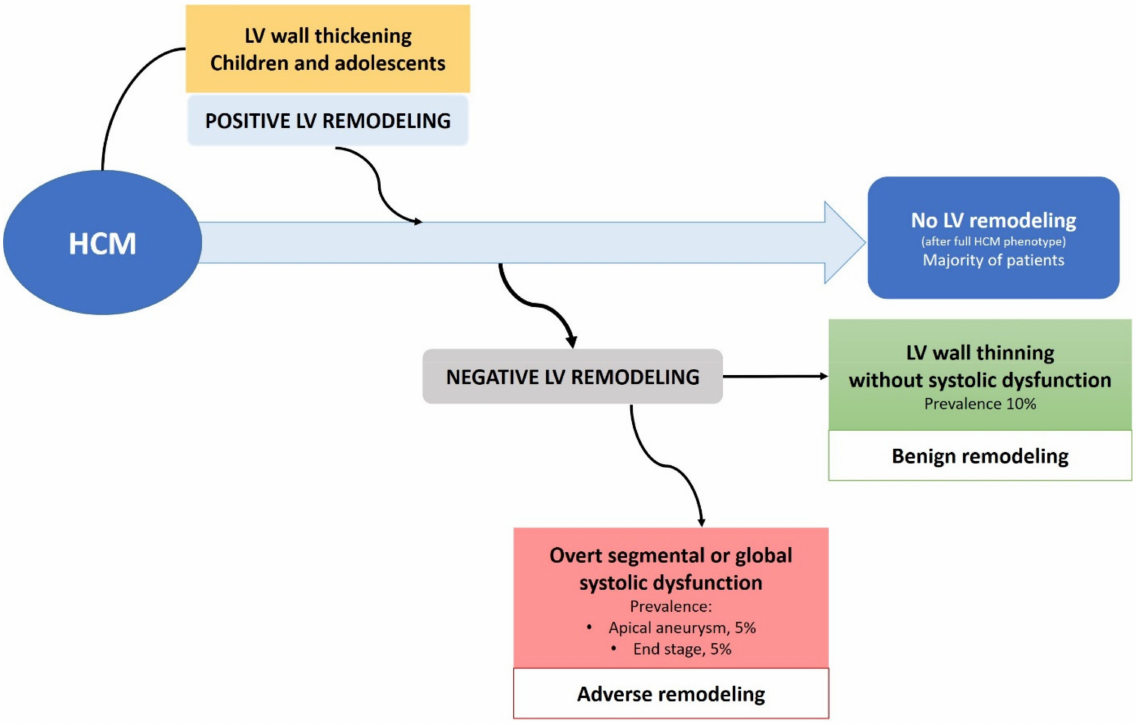
Figure 2. Different patterns of LV remodeling occurring during the clinical course of